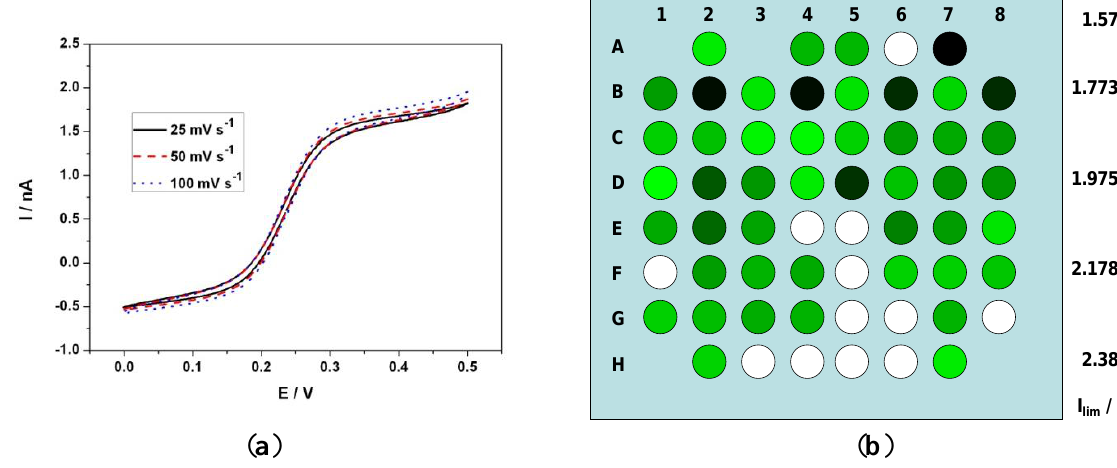
Figure 4. ( a ) Cylcic voltammogram of an electrode at 25, 50 and 100 mV∙s −1 in 0.5 M potassium chloride aqueous solution containing 1 mM Fe(CN) 64− ion and ( b ) RGB model of an 8 × 8 electrode array where each electrode is represented by a circle and the green component value corresponds to their respective i value. lim